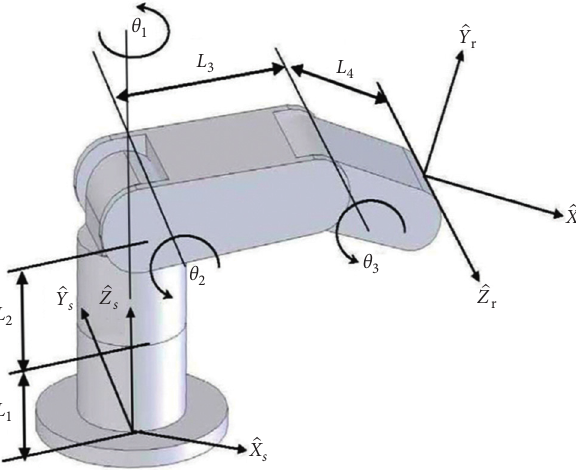
Figure 3: RRR spatial robot arm